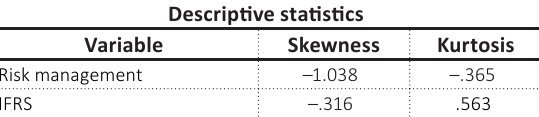
Table 1. Normality result